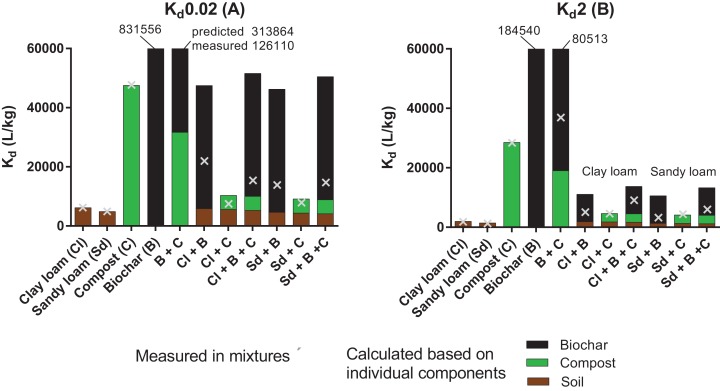
Measured sorption coefficients (×) of pyrene at 0.02 mg/L (A) and 2 mg/L (B) compared to Kd values calculated with an additive model (whole bars).The bars show the contribution of soil (brown portion), compost (C, green portion) and biochar (B, black portion).